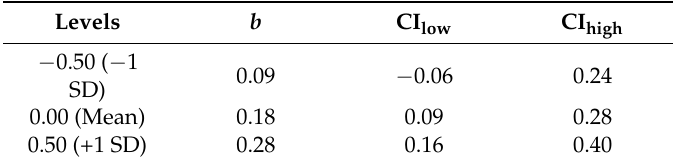
Table 5. Moderating effect of coworker support.